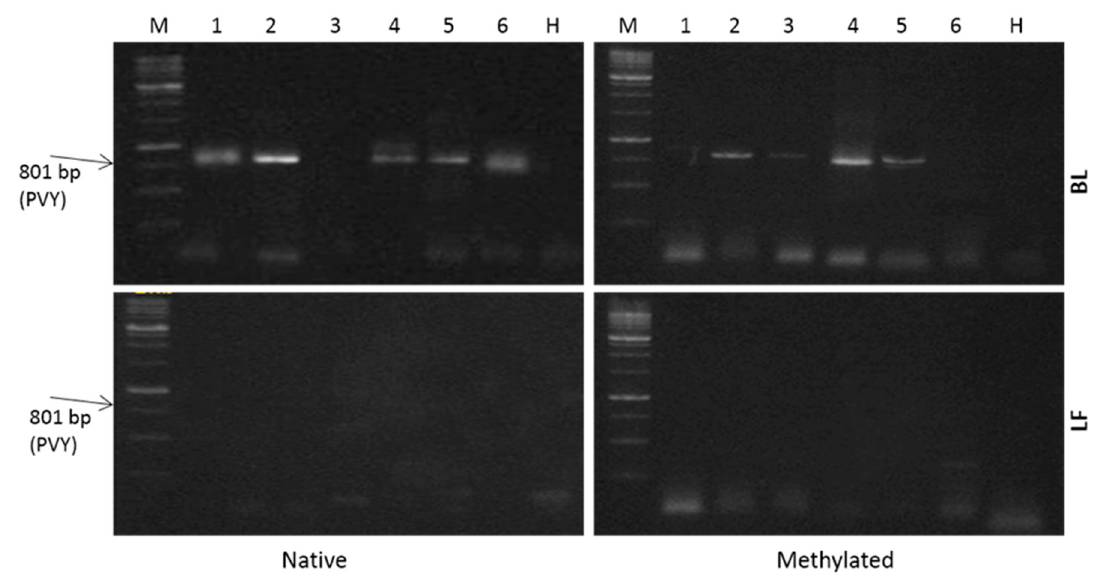
Figure 3. Detection of PVY in the leaves of treated potato plants using dot blot hybridization technique in the leaves of potato cultivated under open field conditions and treated once with 500 μ g mL − 1 (15 days after the viral infection) of BL and LF or BLM and MLF. The numbers from 1 to 10 refer to different potato plant samples of the same treatment and + ve is the positive control. The negative control was run separately and did not show any spot (data not shown). Ten representative plant samples out of a total of 15 plants/treatment were randomly selected and used in this analysis.